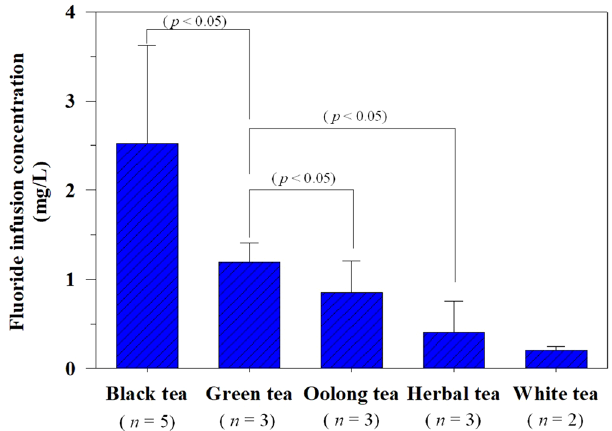
Figure 1. The content of fluoride in the various tea and herbal infusions after 5 min of